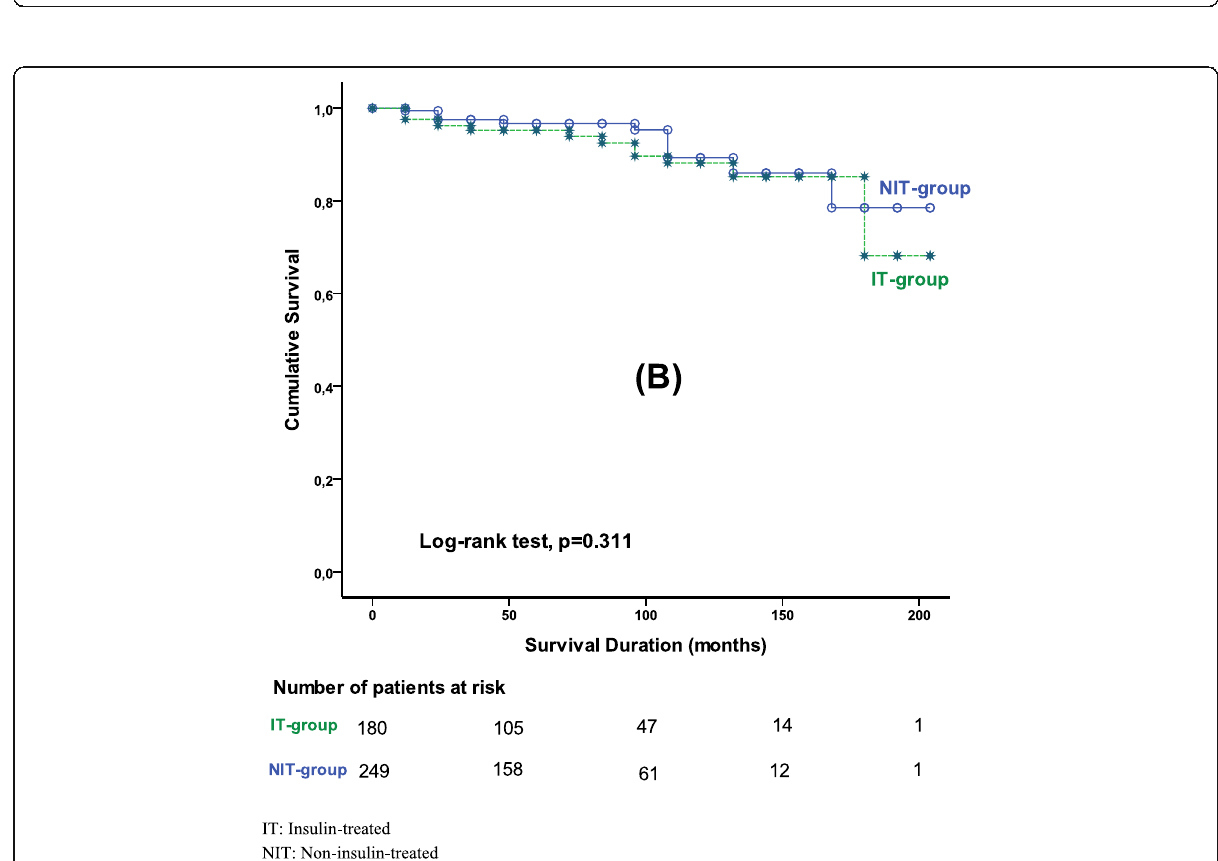
Fig. 1 Kaplan-Meier survival curve (A) for the whole cohort with all patients enrolled in the study